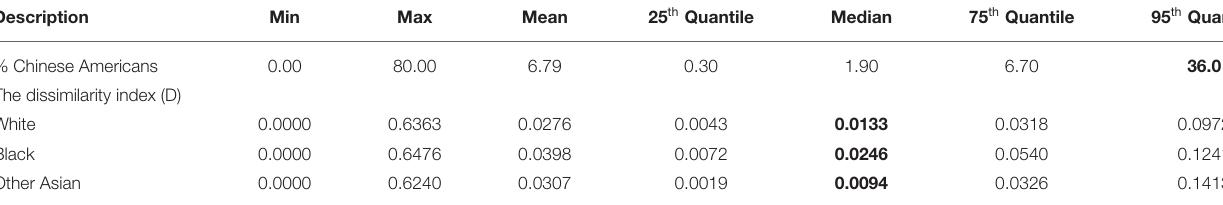
TABLE 3 | Descriptive statistics used in defining ethnic enclaves, 2016.